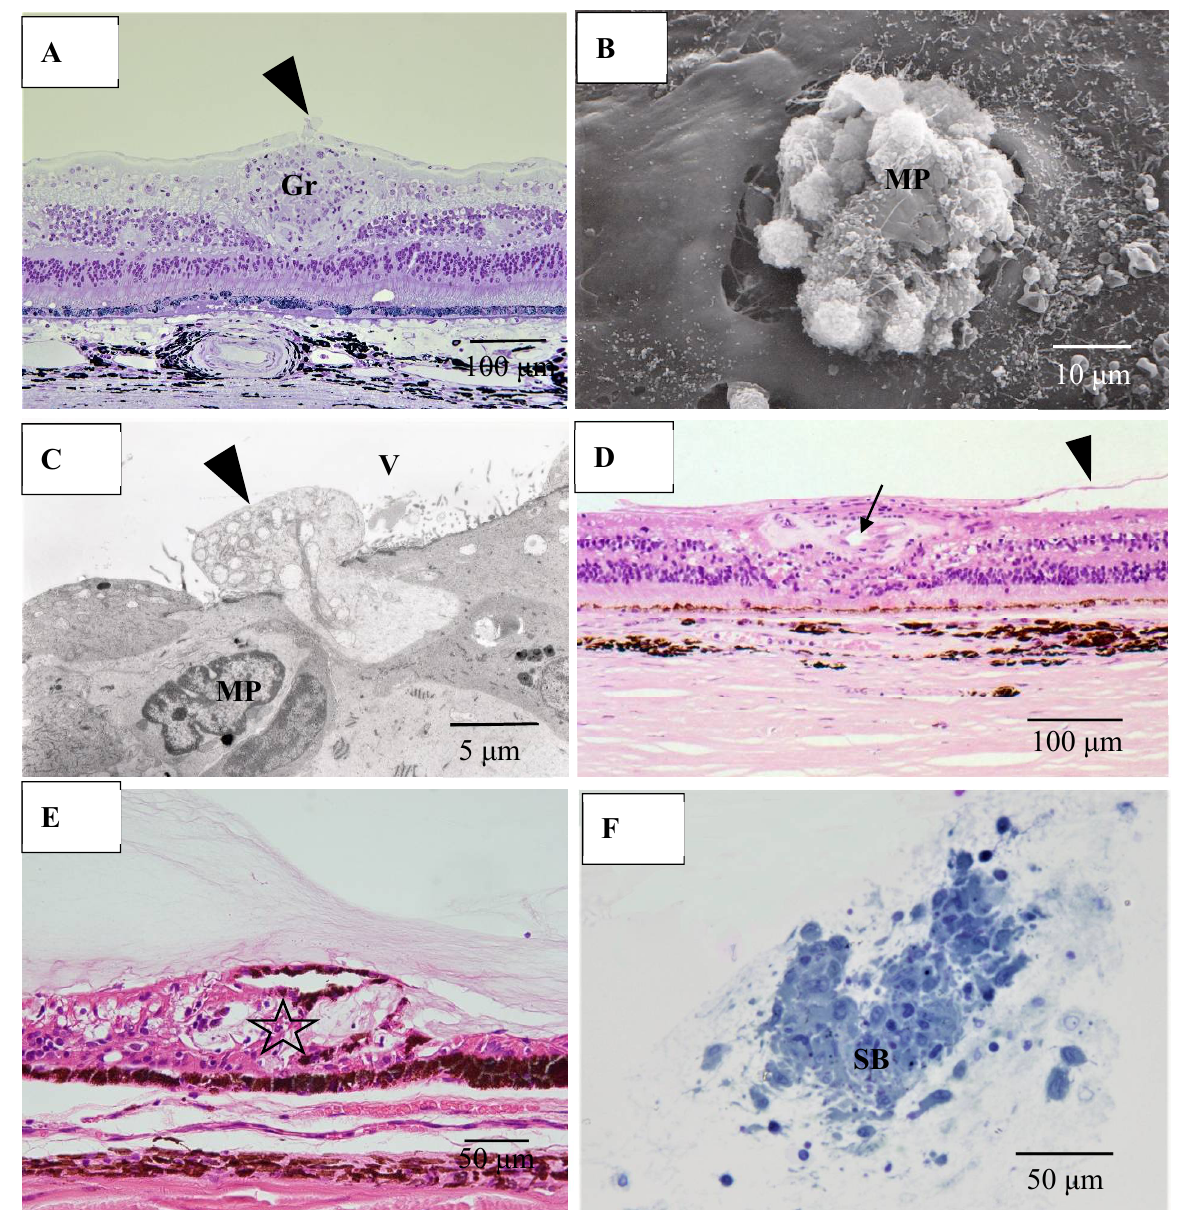
Figure 15. ( A ) Light microscopy photograph granuloma (Gr) in the retina taken from the transitional area from radial peripapillary capillaries to the mid periphery in the right eye of Autopsy Case 2, a 78-year-old female (methylmethacryrate embedding, toluidine blue stain); ( B ) Scanning electron microscopy photographs of granuloma extending from the retina to the vitreous in the right eye of Autopsy Case 1, a 75-year-old female; ( C ) Transmission electron microscopy of granuloma in the left eye of Autopsy Case 1; ( D , E ) Light microscopy photographs of the retina in the mid periphery ( D ) and extremely periphery ( E ) in the left eye of Autopsy Case 1. Hematoxylin & eosin stain, paraffin embedding; ( F ) Light microscopy photograph of snowball vitreous opacity obtained from a vitrectomy sample. Epon embedding, toluidine blue stain. Macrophages (arrowheads in A , C and MP in B , C ) invading from retina into the vitreous (V). Proliferative tissue (arrowheads in D ) consisting of fibrotic tissue with lymphocytic infiltration adjacent to the retinal vein (arrow in D ) extending from the retina to the vitreous. Vitreoretinal adhesion where the retina became degenerated (star in E ) was observed in the extreme peripheral area. The snowball (SB in F ) opacity is granuloma. FFA showed diffuse and strong leakage from blood vessels (figure not shown).